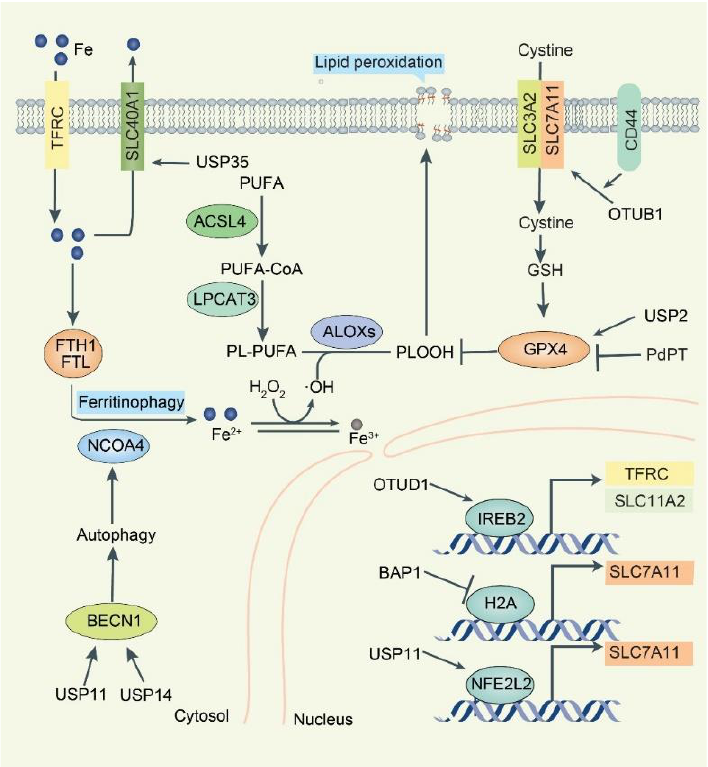
Figure 4. Overview of DUBs-mediated regulation of ferroptosis. Induction of iron-mediated fer- roptosis depends on disruption of the balance of oxidants and antioxidants. SLC40A1 is the only cellular iron exporter. USP35 binds to SLC40A1 to stabilize its expression and inhibit ferroptosis. TFRC uptakes extracellular iron and stores iron through FTH1/FTL. Cell-destabilizing iron release from ferritin is dependent on NCOA4-dependent ferrotinophagy. Labile iron promotes the production of PL-OOH, which leads to membrane lipid oxidation and cell death. BECN1 promotes autophagy and ferrotinophagy. Two DUBs, USP11 and USP14, are responsible for BECN1 deubiquitination. SLC7A11 and SLC3A2 form the amino acid transport system xc–, which uptakes cystine into the cytosol, where it is rapidly converted to cysteine and used for glutathione synthesis. The stem cell marker CD44 promotes OTUB1-SLC7A11 association and stabilizes SLC7A11. Selenium enzyme GPX4 reduces PLOOH and inhibits ferroptosis via glutathione. DUB USP2 stabilizes GPX4, and the pan-DUBs inhibitor PdPT promotes GPX4 degradation. The transcription factor IREB2 is responsible for TFRC and SLC11A2 gene transcription. DUB OTUD1 binds and stabilizes IREB2, while BAP1 promotes SLC7A11 transcription through histone H2A deubiquitination. NFE2L2 is responsible for SLC7A11 transcription and USP11 stabilizes NFE2L2 protein. GPX4 is a selenoprotein that catalyzes lethal lipid hydroperoxides to nontoxic lipid alcohols in the presence of GSH as an essential cofactor. The E3 tripartite motif containing 46 (TRIM46) is one of the E3 ligases of GPX4 in human retinal capillary endothelial cells with high glucose treatment [91]. LUBAC mediates M1-linked ubiquitination of GPX4 to stabilize GPX4 under normal conditions or oxidative stress [92]. RSL3 induces rapid